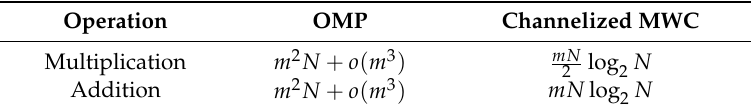
Table 2. Amount of Calculation